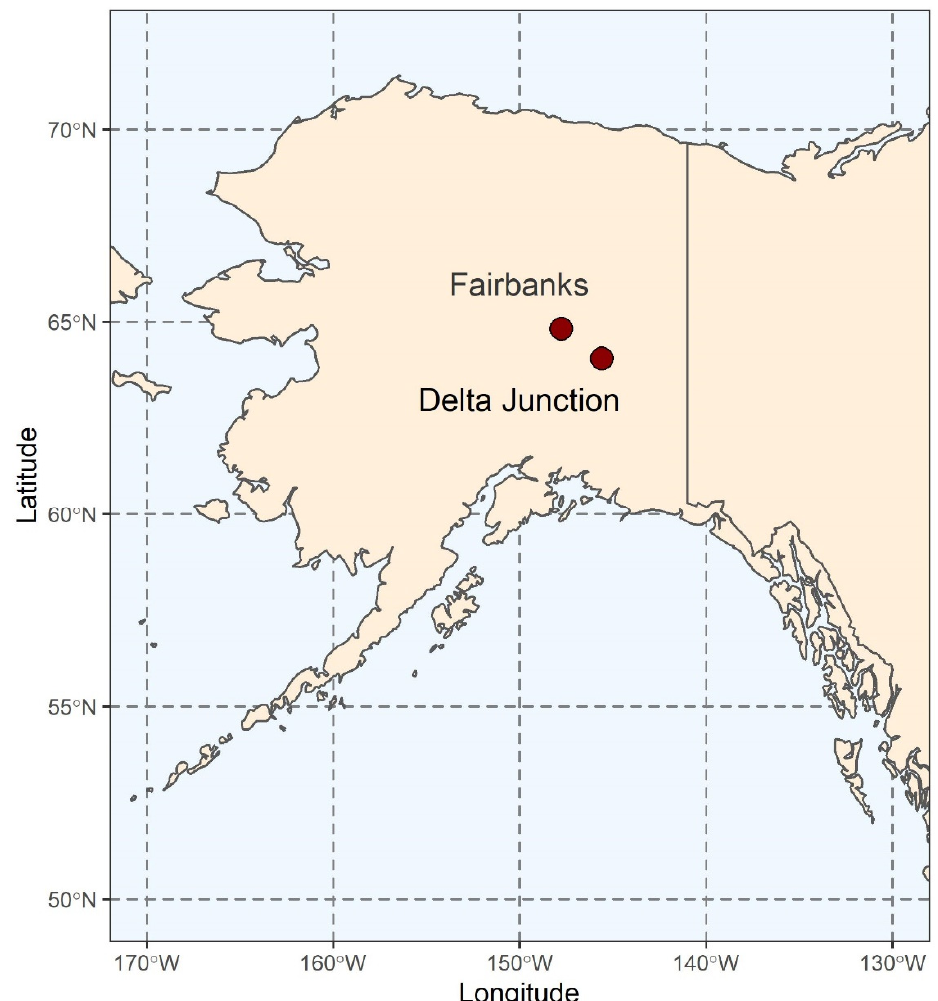
Figure 1. Map with latitude and longitude showing the locations of two testing sites in Alaska, USA.